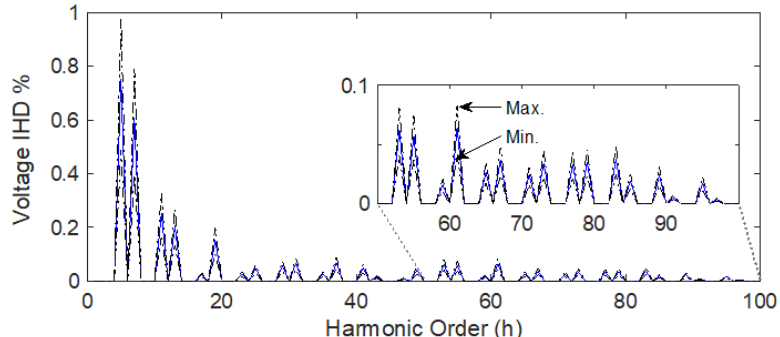
Figure 12. Voltage distortions variations at the PoC using the proposed MCS-based